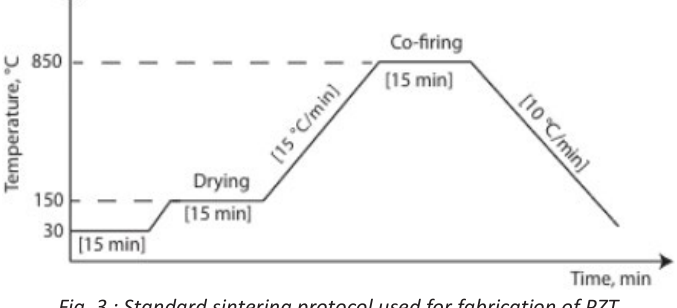
Fig. 3 : Standard sintering protocol used for fabrication of